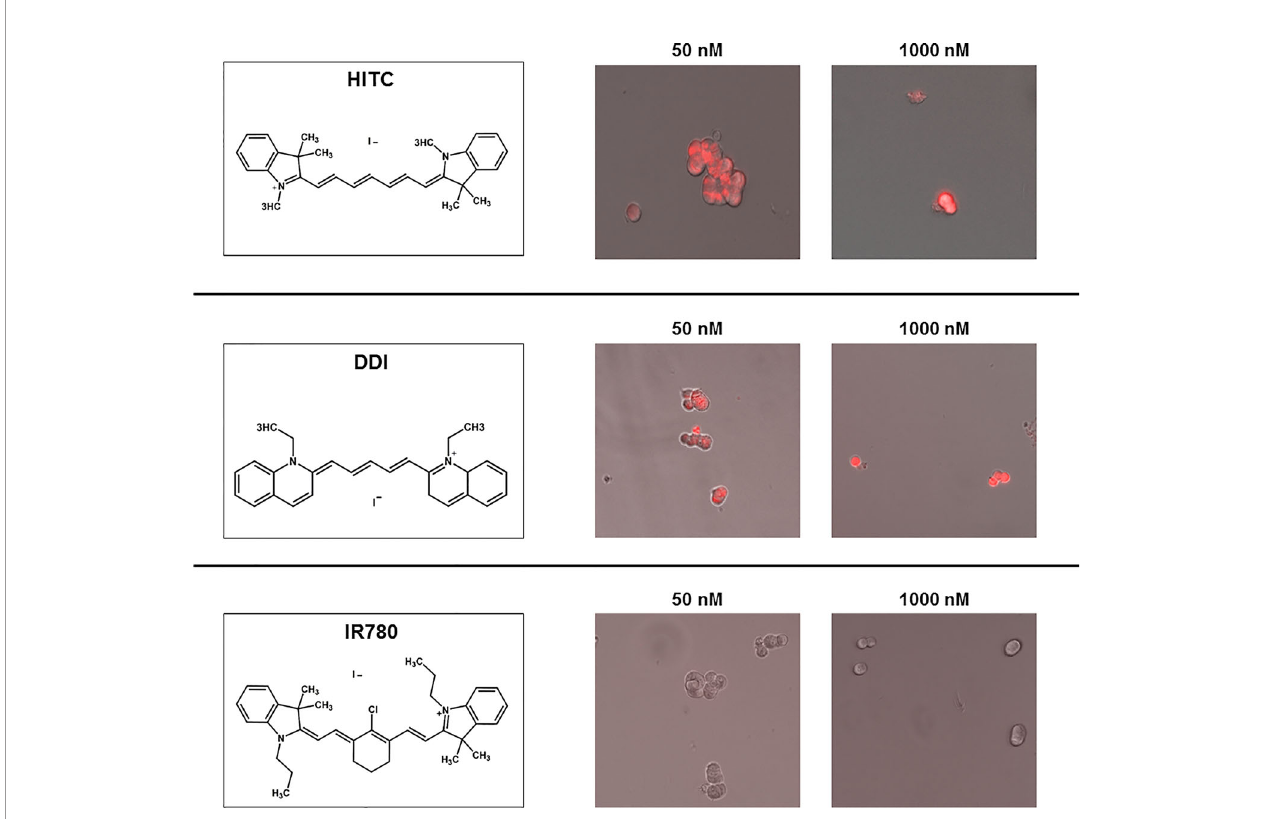
FIGURE 8 | Structure and uptake of NIR compounds in MCF7 cells. (Left). Near-infrared (NIR) compounds. Chemical structures of HITC (B-1,1 ’ ,3,3,3 ’ ,3 ’ - Hexamethylindotricarbocyanine iodide), DDI (1,1 ’ Diethyl-2-2 ’ -dicarboccyanine iodide) and IR780 (2-[2-[2-Chloro-3-[(1,3-dihydro-3,3-dimethyl-1-propyl-2H-indol-2- ylidene)ethylidene]-1-cyclohexen-1-l]ethenyl]-3,3-dimethyl-1-propylindolium iodide). NIR compounds present a characteristic peak fl uorescent emission in the NIR light spectrum. (Middle and Right). MCF7 mammosphere cellular uptake. Treatment of mammospheres using 50 nM and 1000 nM concentrations of HITC, DDI and IR780 for fi ve days. Note that HITC and DDI is localized within the cell and was observed with the Cy5 channel (near infrared signal), whereas IR780 cellular uptake was not detectable, even at higher concentrations.